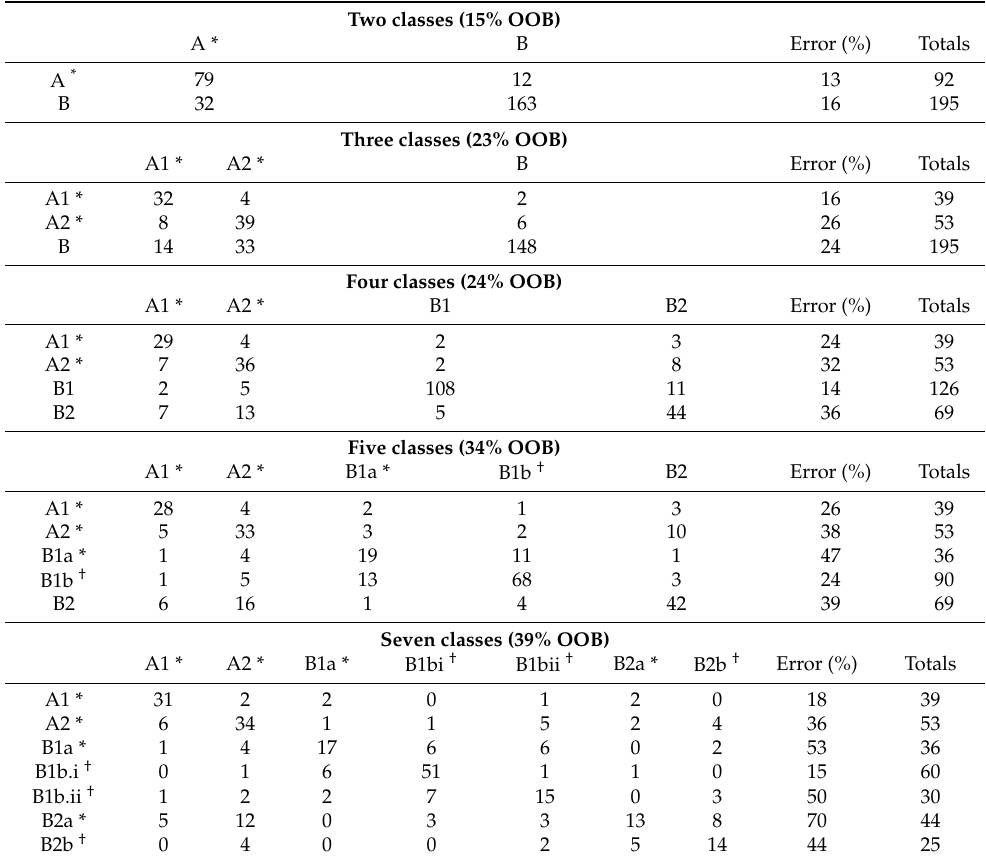
Table 4. Confusion matrices for the two- to seven-group hierarchical classification models showing model performance as out-of-bag (OOB) error. Classes with over 90% nonperennial reaches are marked with a *. Classes with 100% perennial reaches are marked with a †. Observed classes are rows, and predicted classes are